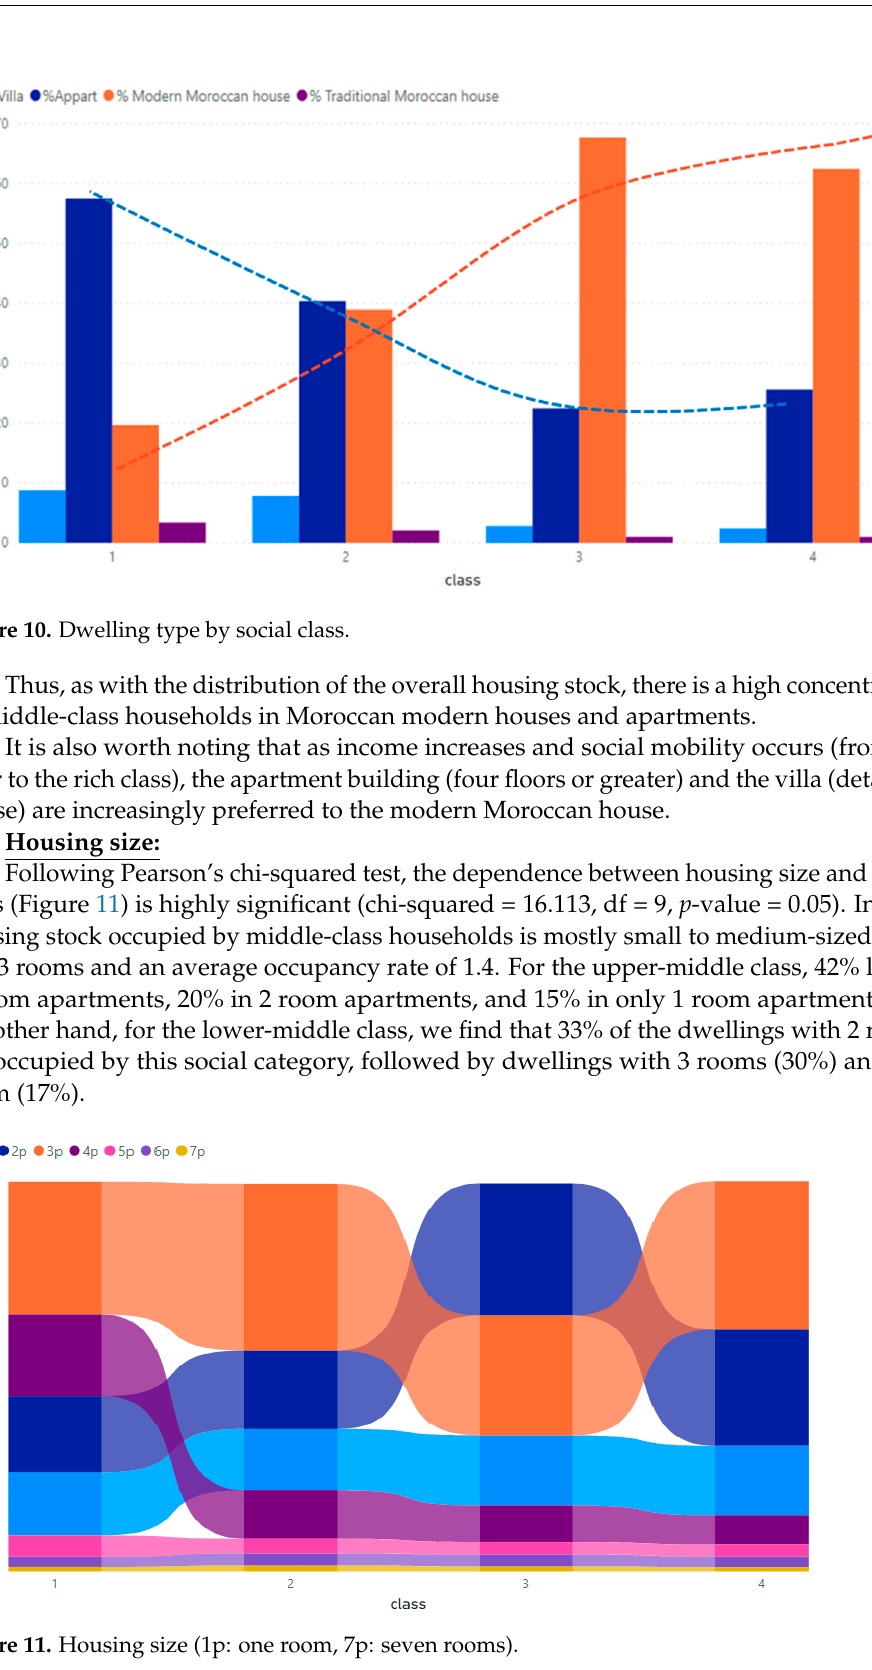
Figure 12. Rate of occupancy by household according to social class. Dwelling age: The overall housing stock in Casablanca is relatively new as almost 68% of housing is less than 50 years old, according to 2014 statistics (37% between 20 and 50 years and 31% less than 20 years). By decomposing this stock according to social classes (Figure 13), the distribution of housing occupied by the upper-middle class according to their age shows that 45% of the housing stock is less than 20 years old (thus exceeding the average for the entire stock) and 28% is between 20 and 50 years old. On the other hand, data on the age of lower-middle-class housing show that only one out of 10 (11%) were built during the 2004–2014 intercensal period. About 50% of the dwellings are between 20 and less than 50 years old. High-income class/rich Lower-middle class